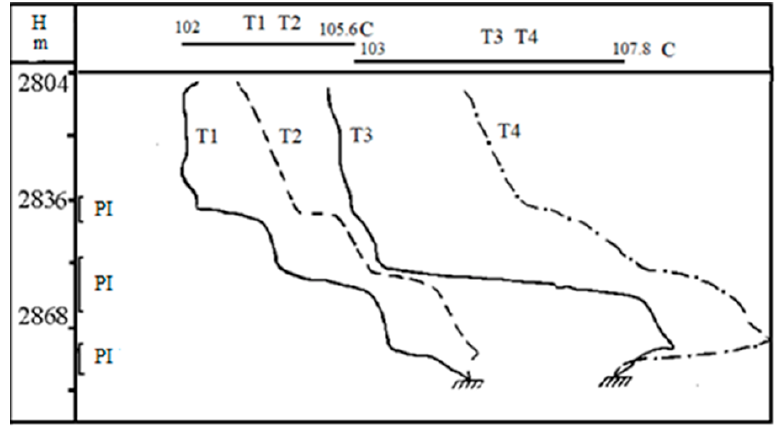
Figure 9. The results of well test. Here, curves T1 and T3 relate to a working well, curves T2 and T4 relate to a shut-in well (PI is the perforation interval) [28 ].